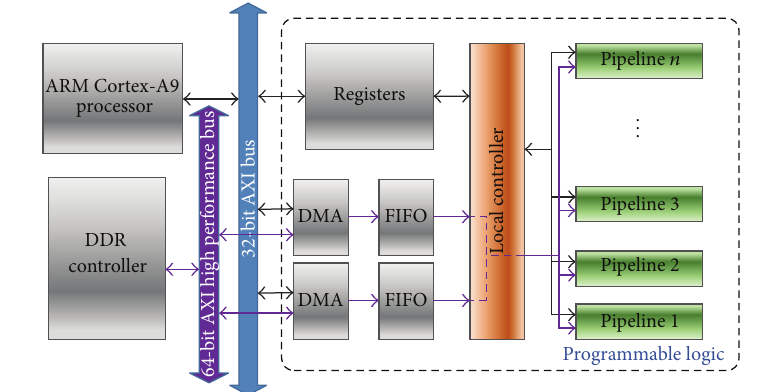
Figure 3: System